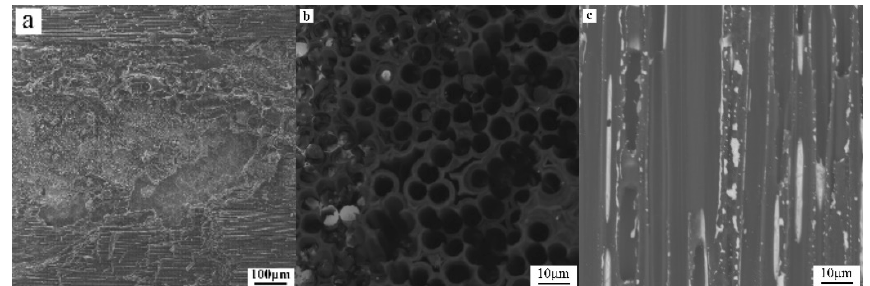
Figure 8. OM macroscopic fracture morphology of brazed joint: ( a ) TiAl side, ( b ) C/C composite side.